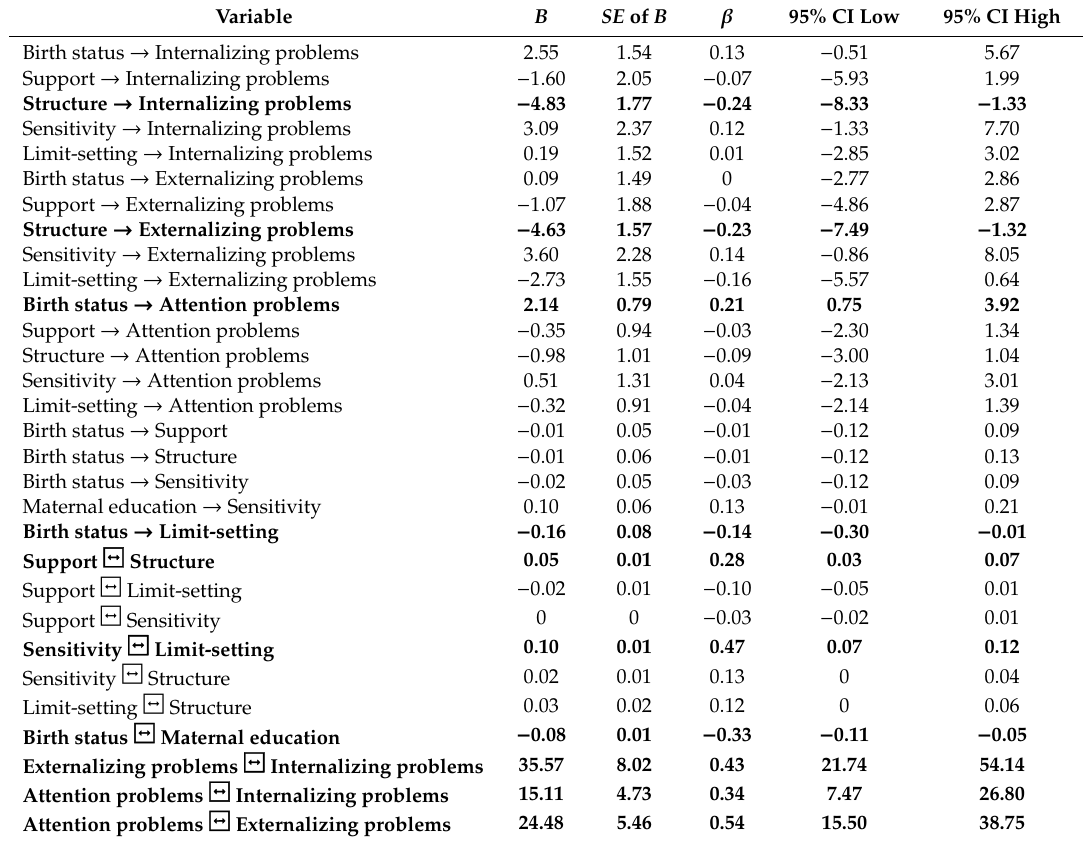
Table 4. Parameter estimates of the final model predicting internalizing, externalizing and attention problems.